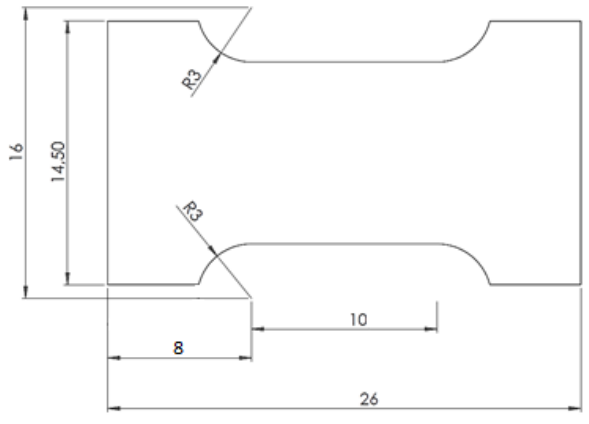
Figure 4. Base material sample for tensile testing.